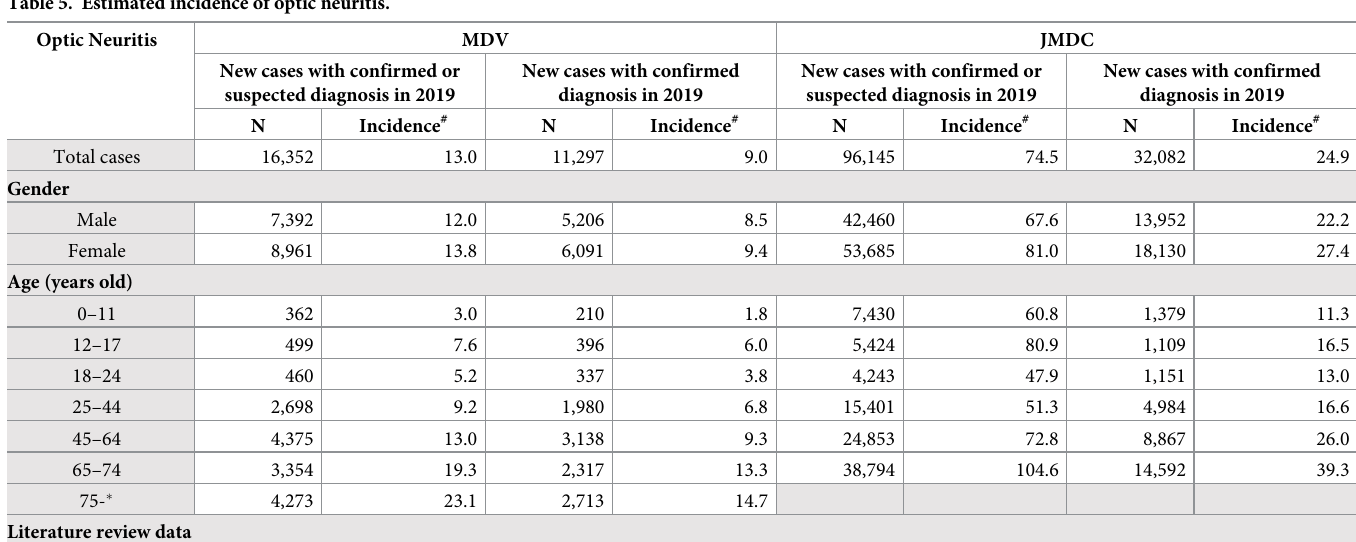
Table 5. Estimated incidence of optic